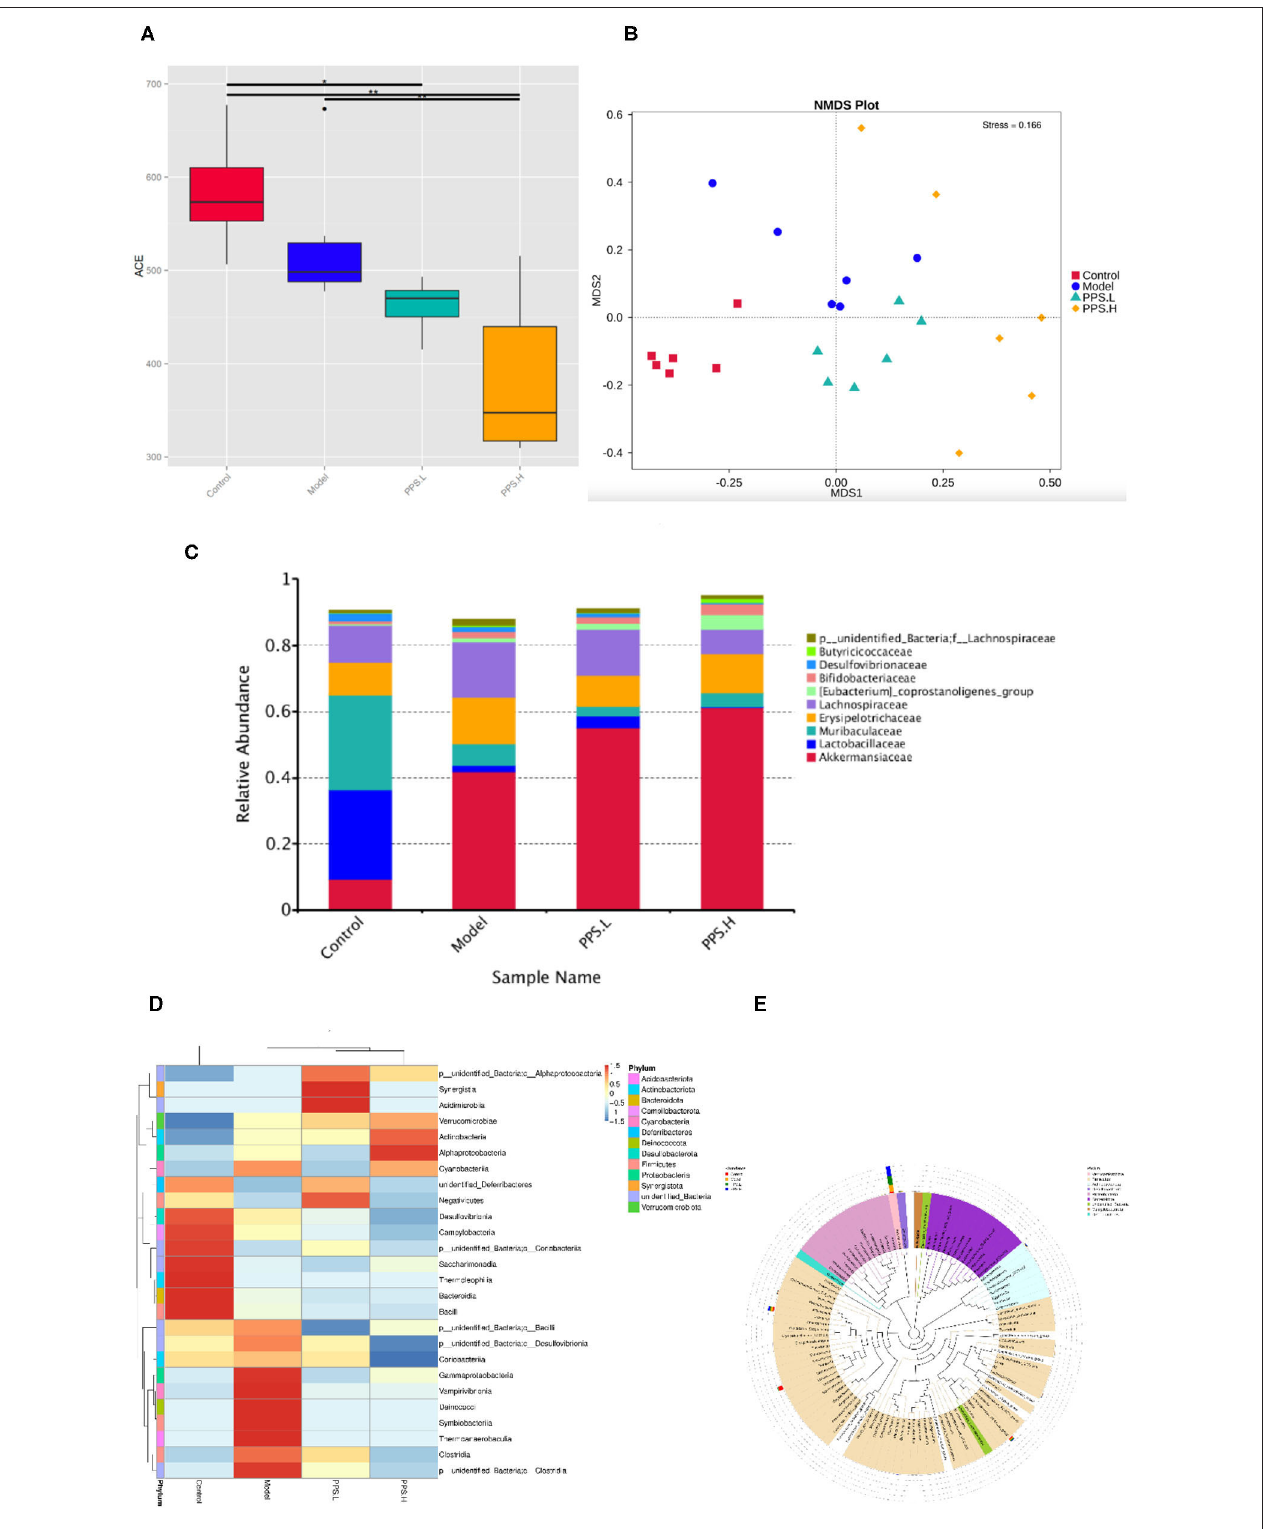
FIGURE 9 | Regulation of PPS on the imbalance of intestinal microbiota in T2DM mice. All mice were sacrificed and colonic samples were collected for 16SrDNA gene sequencing. (A) Alpha diversity index-observed species. (B) Beta-diversity-NMDS. (C) Alteration of gut microbiota composition at family level. (D) Heatmap of genera level of each sample. (E) Phylogenetic tree of the genus